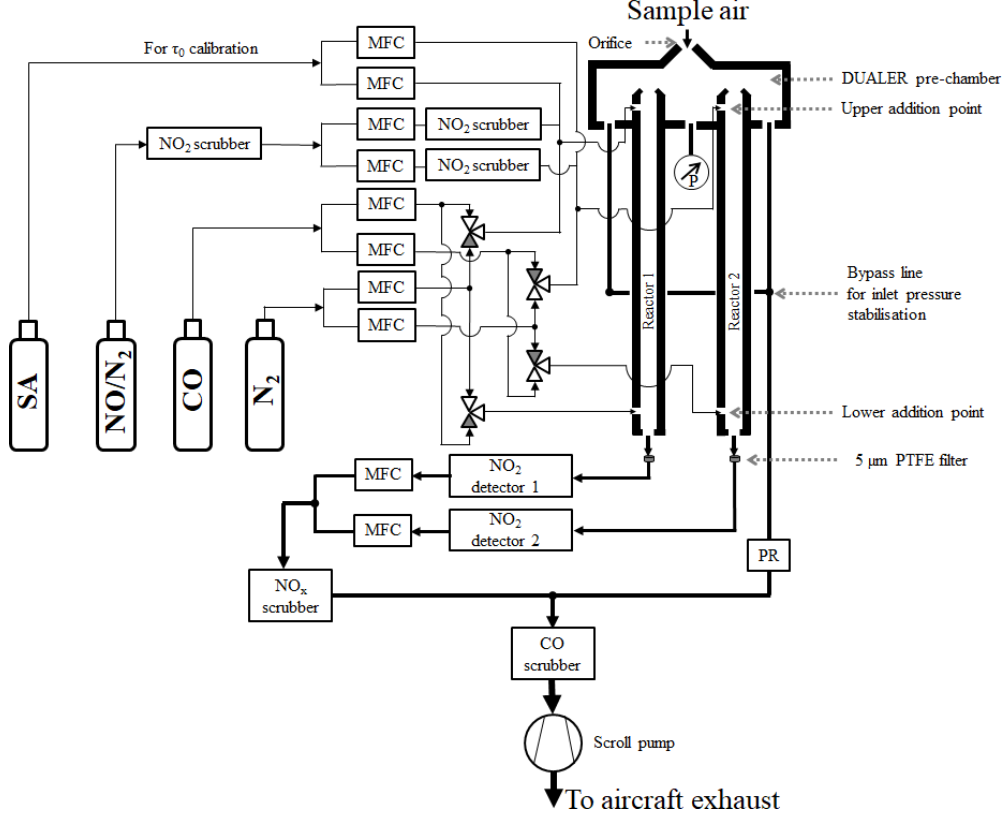
Figure 1. Schematic diagram of the PeRCEAS instrument. SA: synthetic air; NO / N 2 : mixture of NO in N 2